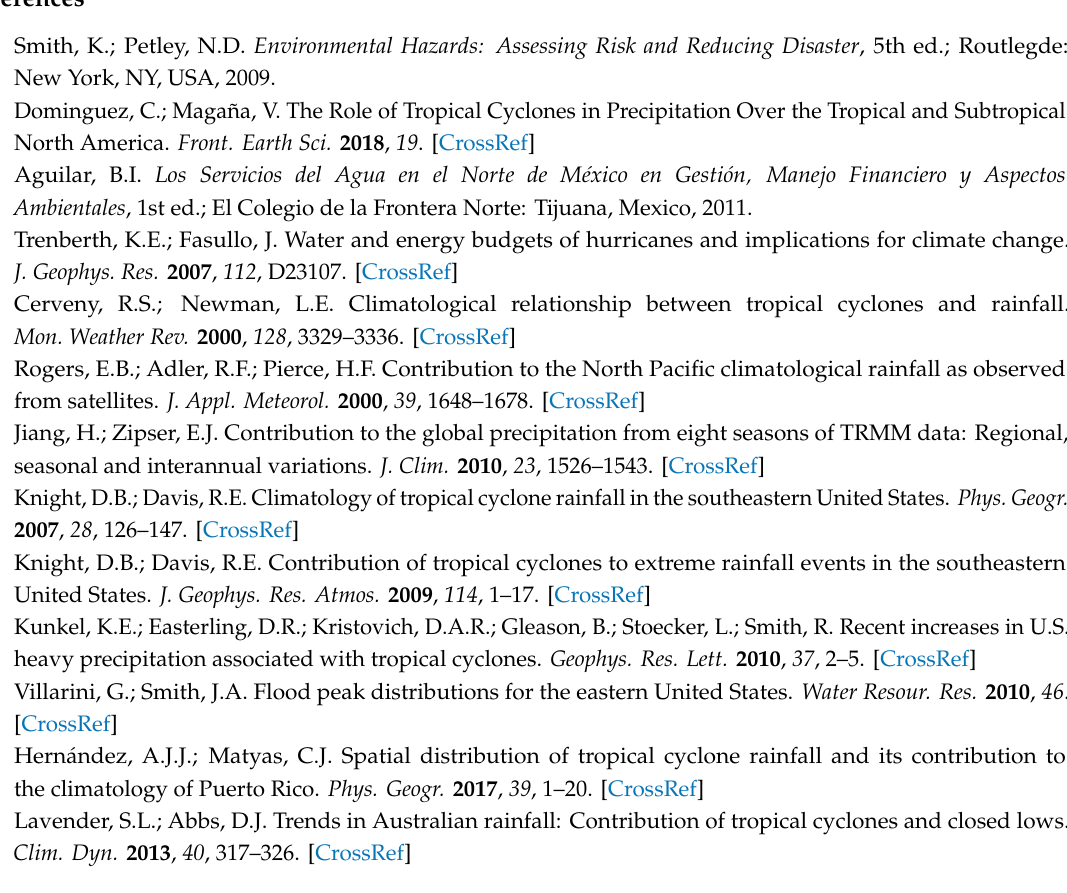
Table S1: Name of TCs that a ff ected Cuba during each month of the cyclonic season in the period